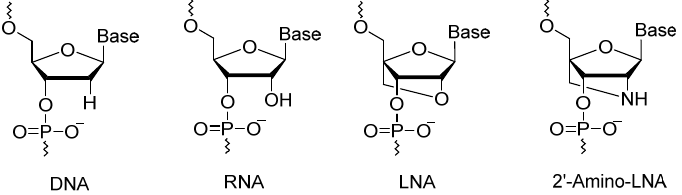
Figure 1. Chemical structure of DNA, RNA, LNA, and 2 ′ -amino-LNA nucleotide monomers.